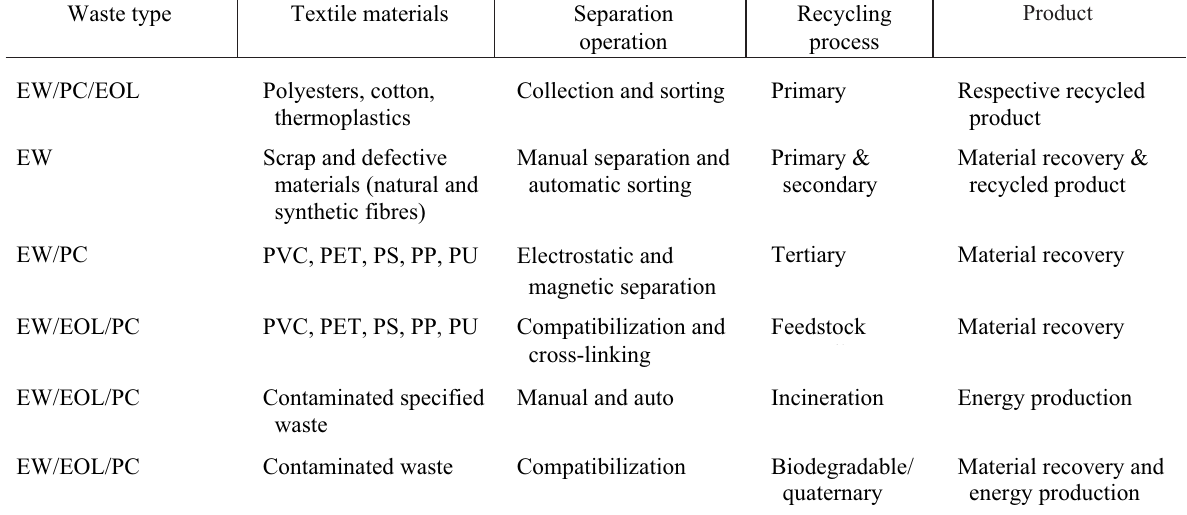
Table 1. Commercial post­consumer waste and recycling